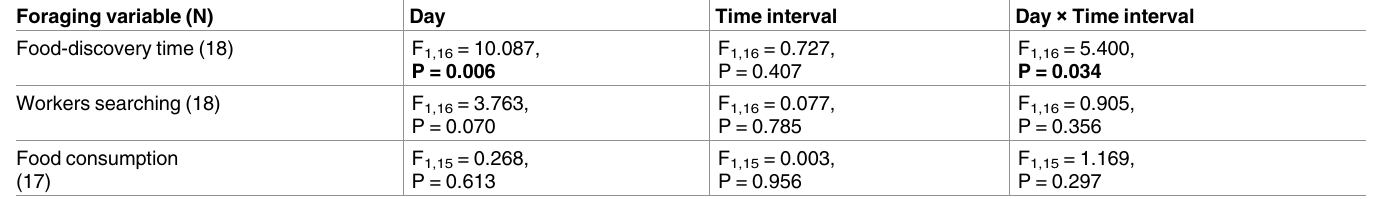
Table 3. The effect of day (before and after the time interval) and the time interval between days on the three foraging response variables. N = sample size (number of colonies). Foraging variable (N) Day Time interval Day × Time interval Food-discovery time